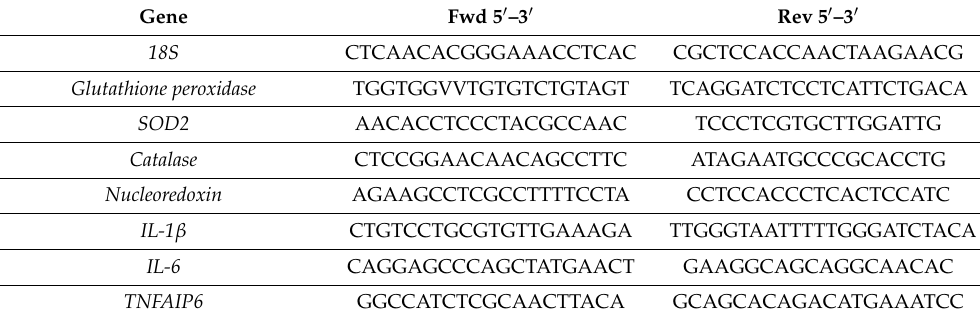
Table 2. Primers used for q-PCR